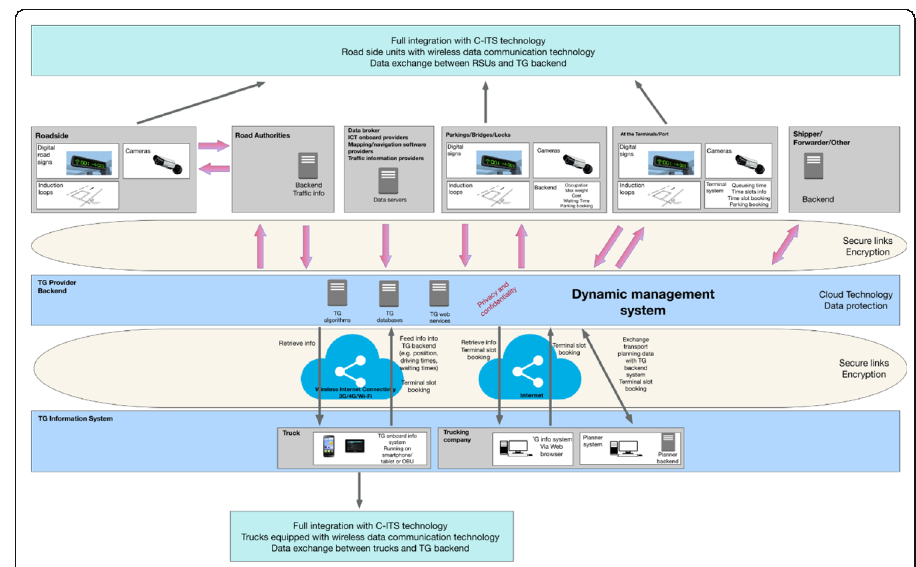
Fig. 4 Fully automated TGS architectural design [Source: own composition based on